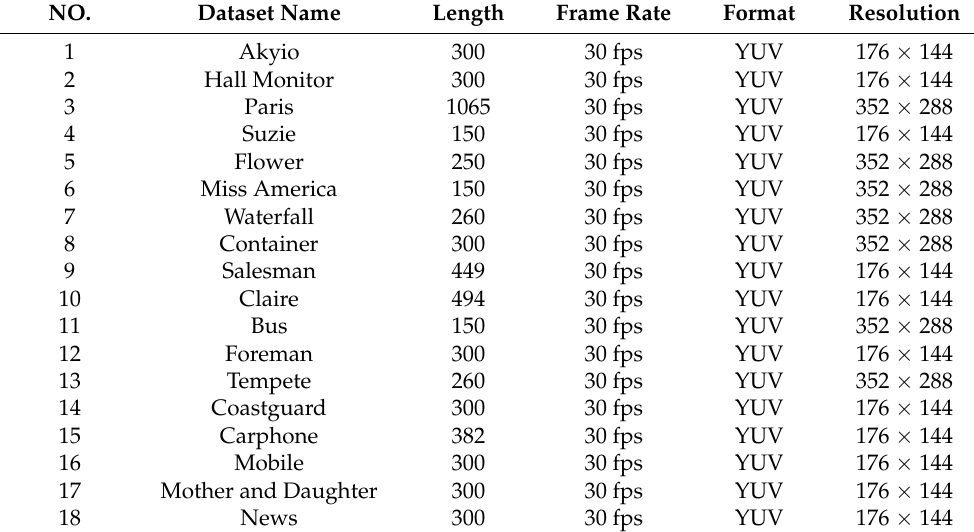
Table 3. Tested dataset